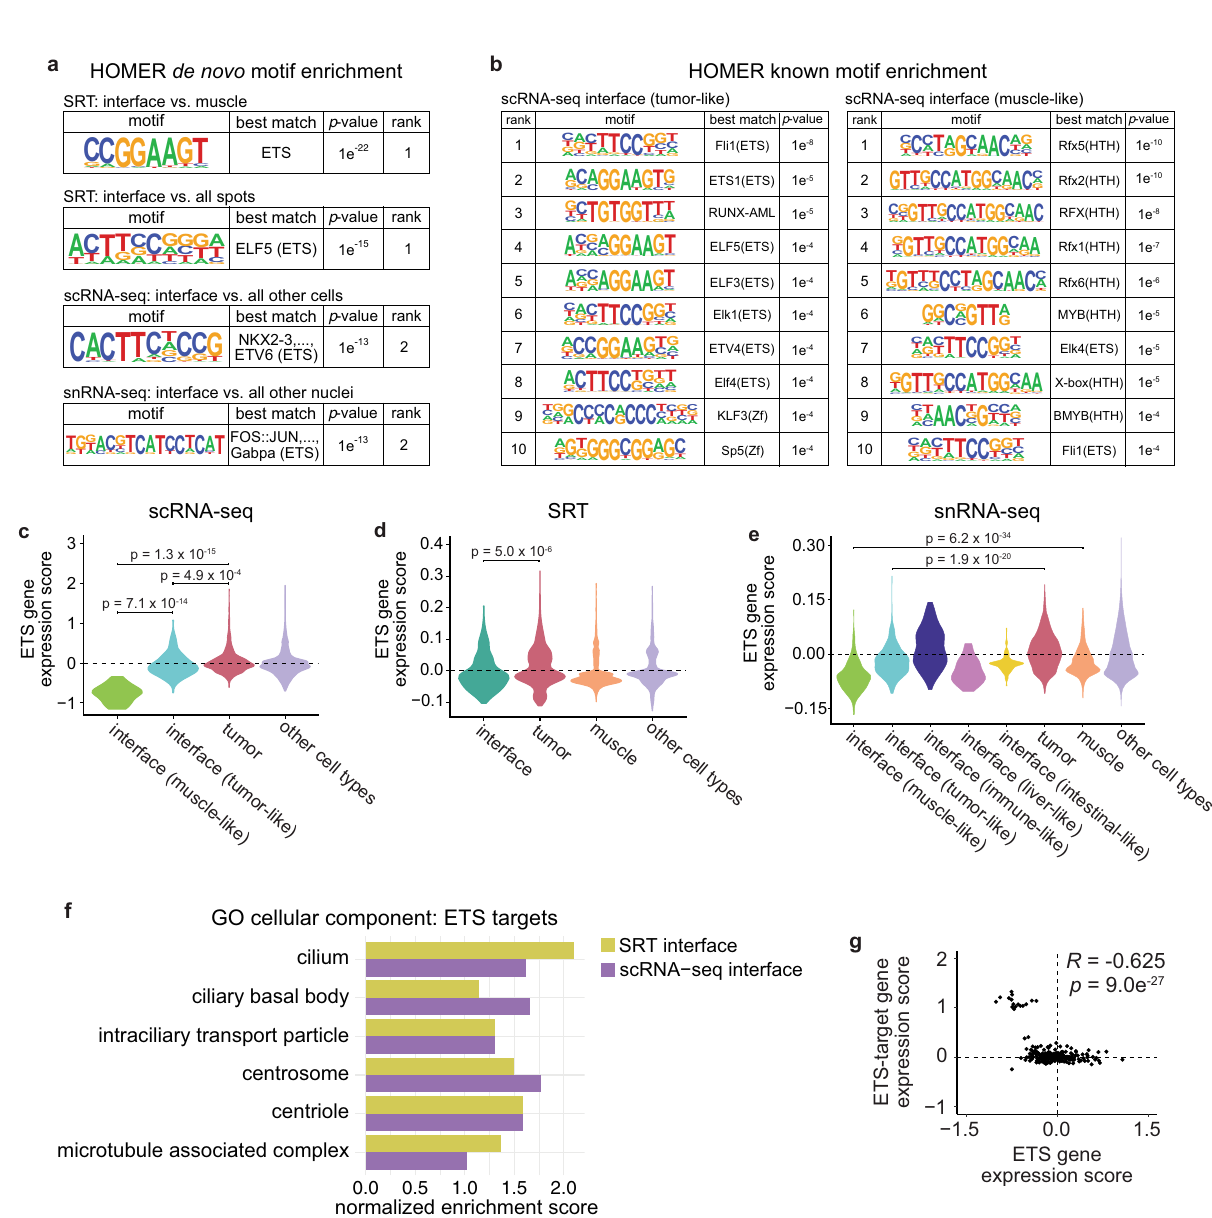
Fig. 5 Cilia genes and proteins are enriched at the tumor – microenvironment interface. a Waterfall plot showing the top and bottom 250 GO cellular component terms by normalized enrichment score (NES) in the scRNA-seq interface cluster, with cilia GO terms labeled in red. b Cilia-related GO term enrichment scores within the tumor-like and muscle-like interface cell states from the scRNA-seq dataset. c Cilia-related GO term enrichment scores for the scRNA-seq and SRT interface clusters. d Relative expression of fi sh SYSCILIA genes in the scRNA-seq interface cluster. e Relative expression of the top 25 SYSCILIA genes upregulated in the scRNA-seq interface cluster across the snRNA-seq clusters. d , e p -values are noted (Wilcoxon rank sum test, two- sided, with Bonferroni ’ s correction). f Normalized expression of selected cilia genes across the snRNA-seq interface clusters. g Immuno fl uorescent images of sections through adult zebra fi sh with invasive melanomas, stained for GFP (tumor cells), acetylated tubulin (cilia), and Hoescht (nuclei), showing the tumor-muscle interface (left), center of the tumor (middle), and distant muscle (right). Arrows denote cilia at the interface. Scale bars, 100 µ m. Images are representative from at least three independent experiments. h Inset of region highlighted in g (left). Scale bars, 25 µ m.